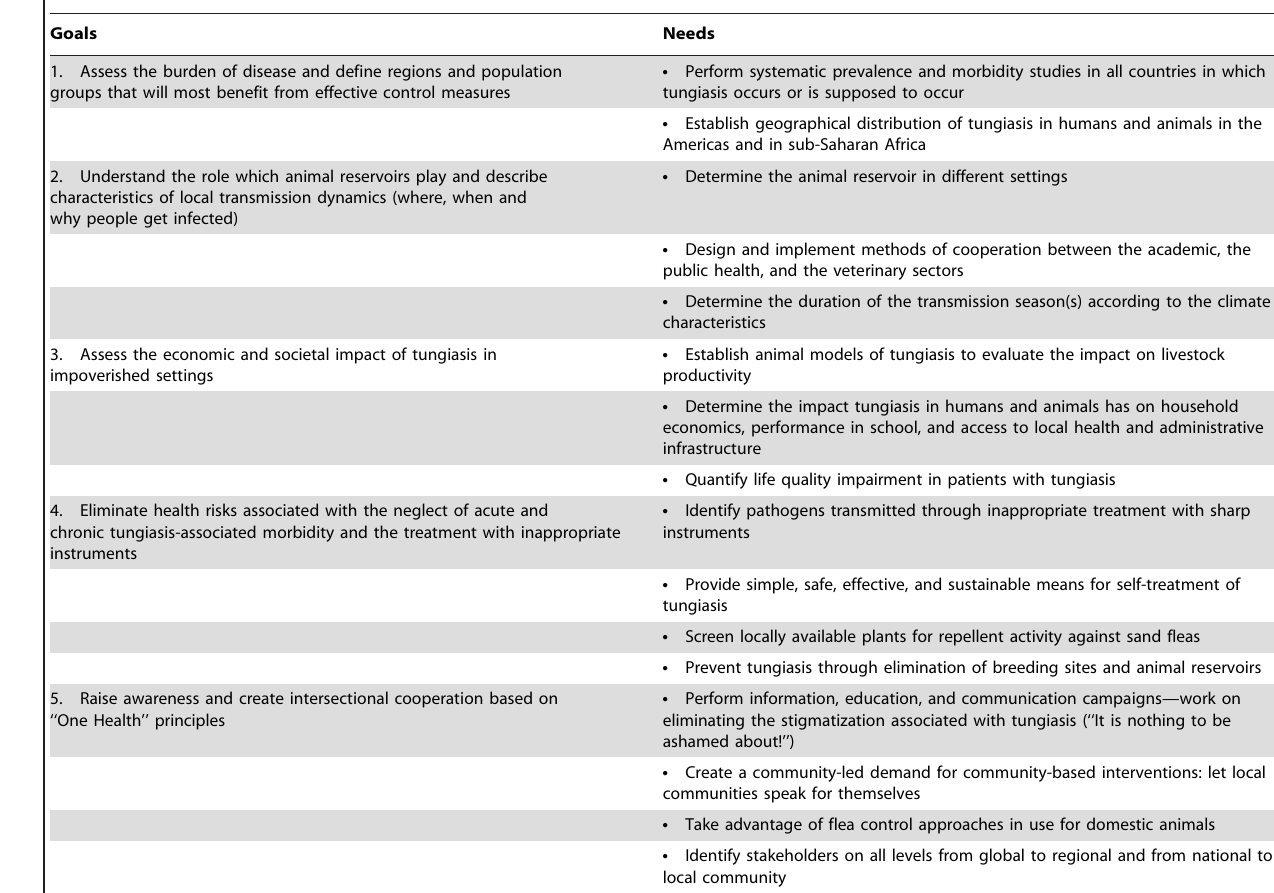
Table 1. Major goals and needs for achievements and control of tungiasis.